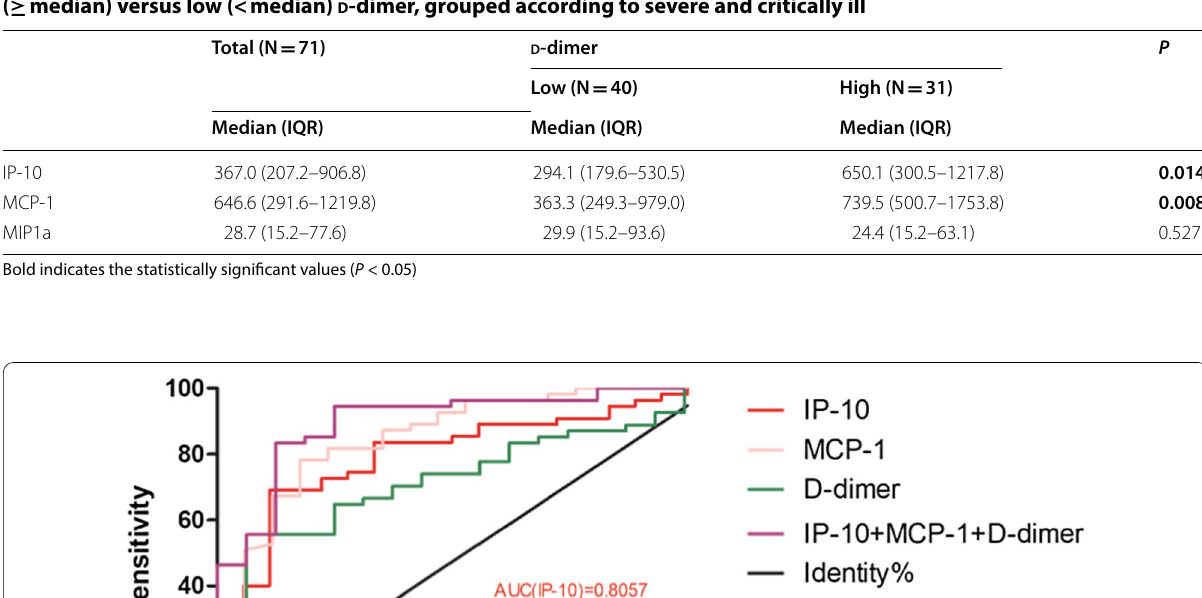
Table 6 Coagulation and thrombosis-related ELISA indicators in 71 COVID-19 patients stratified according to high ( median) versus low (< median) d -dimer, grouped according to severe and critically ill ≥